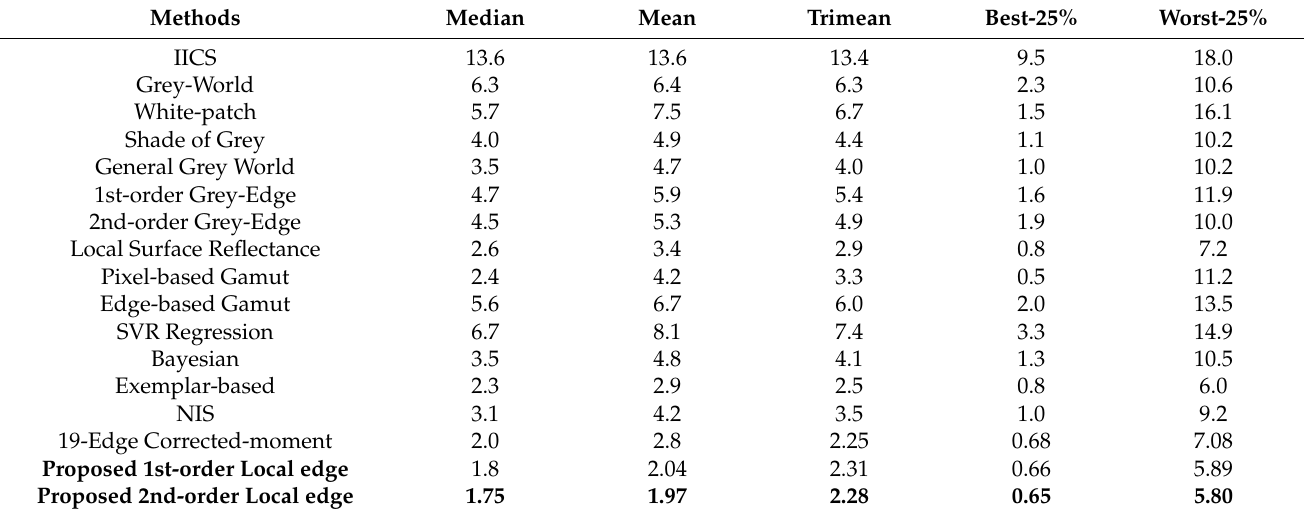
Table 4. Performance of different color constancy methods on the Gehler-Shi dataset.